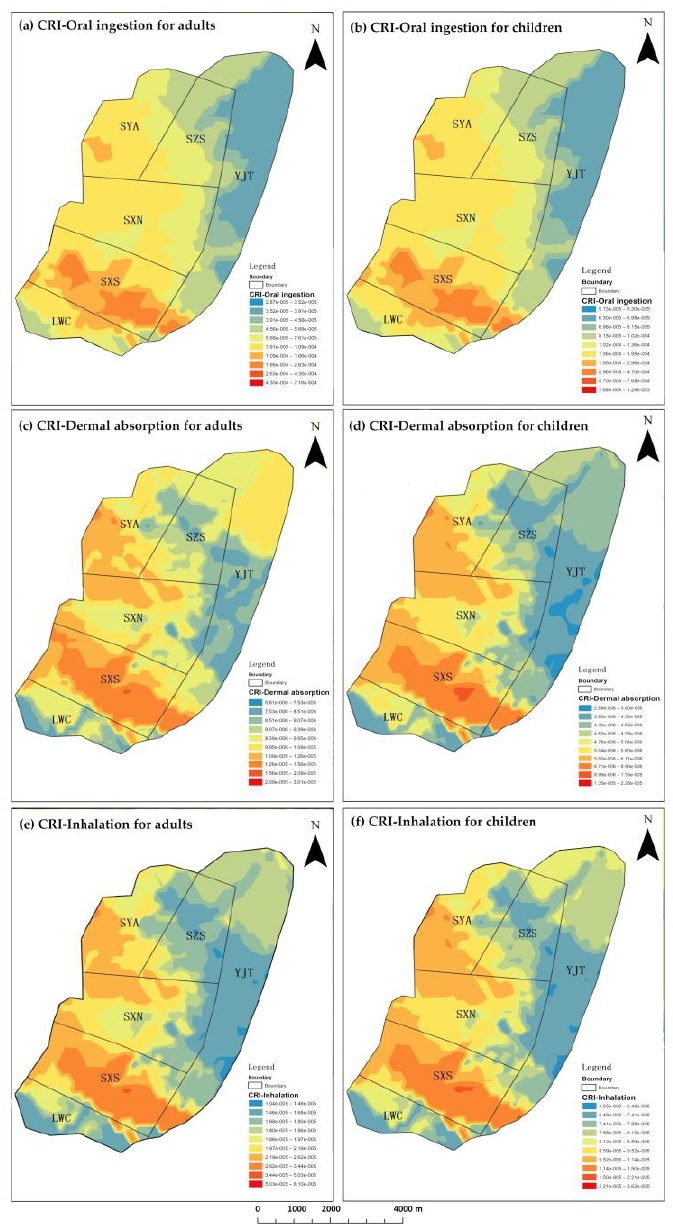
Figure 6. Spatial distribution of Cancer risk index of PTEs from the six sampling